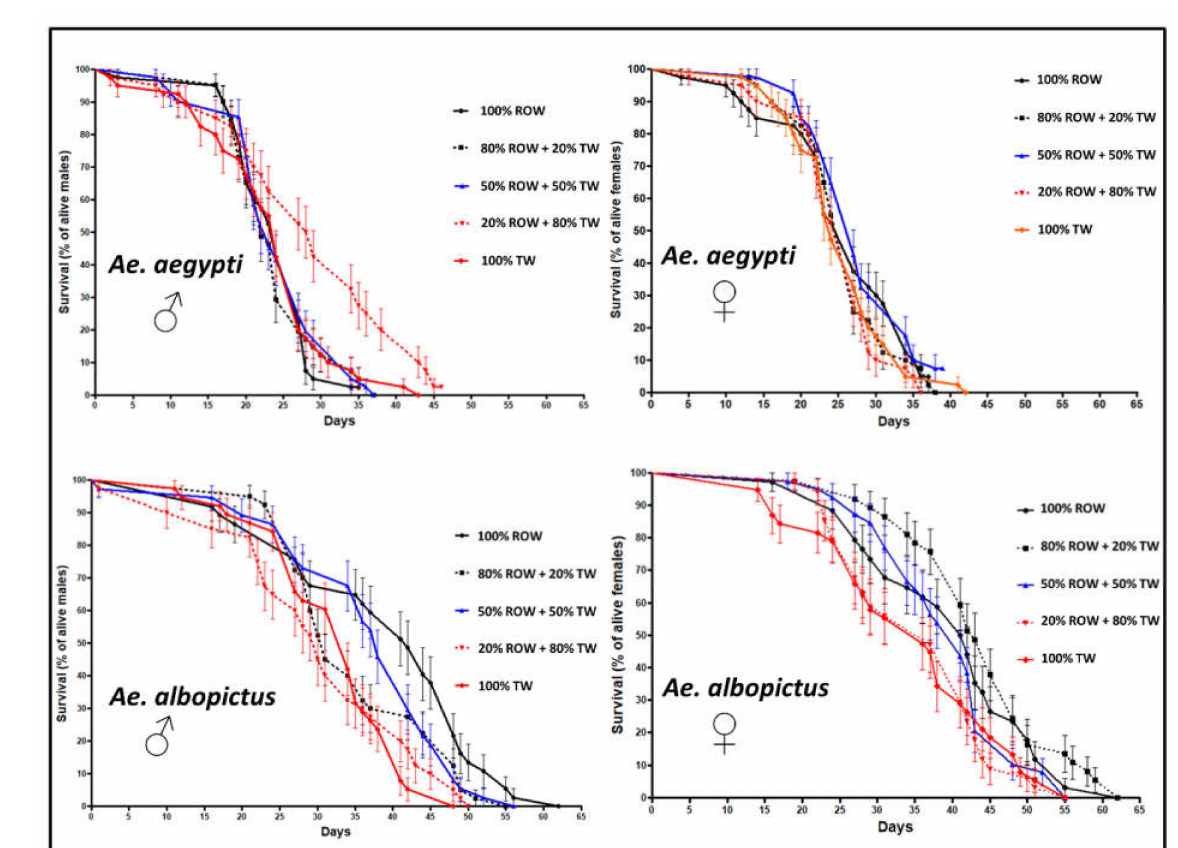
Figure 3. Longevity of male and female Aedes aegypti and Aedes albopictus reared in different hardness/electrical conductivity levels of larval rearing water. ROW = reverse osmosis water, TW = tap water. Table 2. Mean ± se (days) and median survival (days) of Aedes aegypti and Aedes albopictus males and females reared under different water hardness treatments. ROW = reverse osmosis water, TW = tap water. Species Sex Parameters 100% ROW